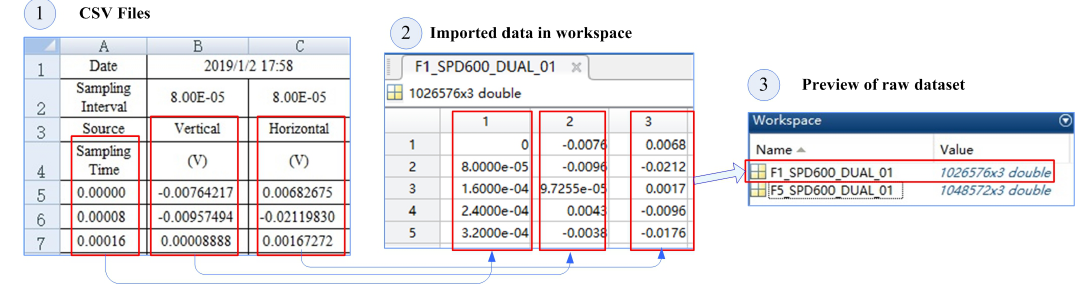
Figure 9. Acquisition of raw datasets.